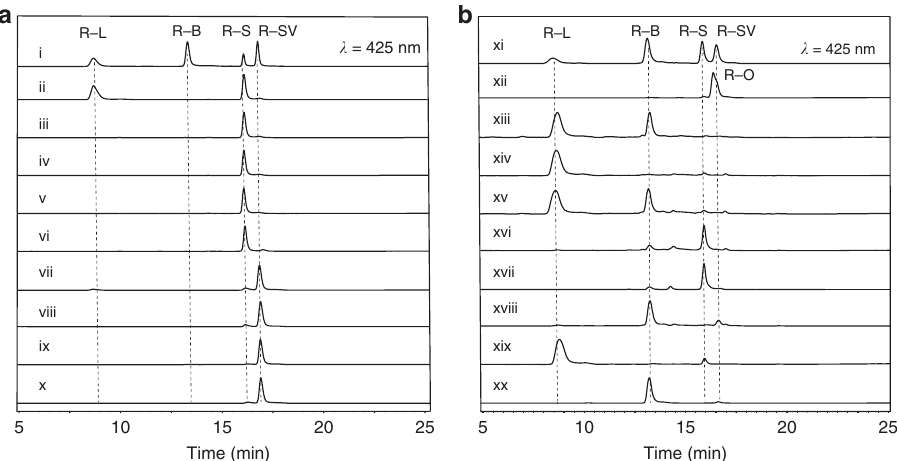
Fig. 2 HPLC analysis of the reactions catalyzed by Rif15 and Rif16. a Reactions catalyzed by the transketolase Rif15. (i) The mixed R-L, R-B, R-S, and R-SV standards; (ii) R-S with Rif15 in the presence of F-6-P, ThDP and Mg 2 + ; (iii – vi) the negative controls of (ii) with the omission of Rif15a (iii), Rif15b (iv), ThDP (v), or Mg 2 + (vi); (vii) R-SV with Rif15 in the presence of F-6-P, ThDP and Mg 2 + ; (viii) R-SV in reaction buffer; (ix) R-SV in reaction buffer with the addition of 2 mM ascorbic acid; and (x) R-SV with Rif15 in the presence of F-6-P, ThDP, Mg 2 + , and 2 mM ascorbic acid. b Reactions catalyzed by the cytochrome P450 enzyme Rif16. (xi) The mixed R-L, R-B, R-S, and R-SV standards; (xii) The freshly prepared R-O authentic standard; (xiii) R-L with Rif16 in the presence of se Fdx, se FdR, and NADPH; (xiv) the negative control of (xiii) with the omission of NADPH; (xv) co-injection of (xiii) with 50 μ M R-B; (xvi) R-L with Rif16 in the presence of 20 mM H 2 O 2 ; (xvii) R-O in reaction buffer; (xviii) R-L with Rif16 in the presence of 20 mM H 2 O 2 and 1 mM NADPH; (xix) R-L with 20 mM H 2 O 2 ; (xx) R-O and 1 mM NADPH in reaction